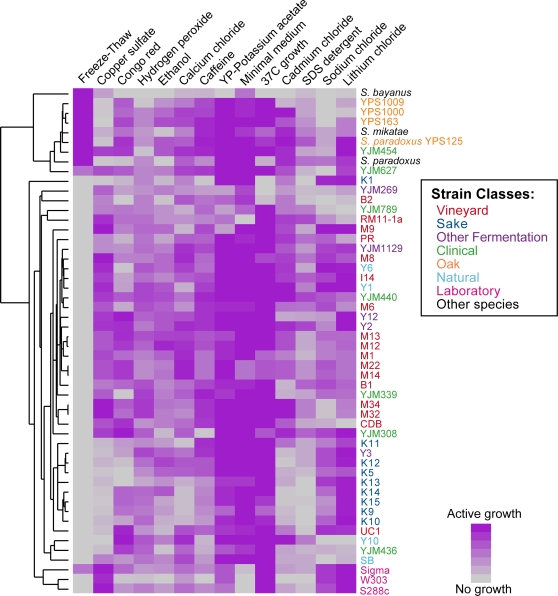
Phenotypic variation in diverse Saccharomyces
strains.The viability of 52 Saccharomyces strains and species
grown under 14 different environmental conditions was measured. Strains
were grown in at least duplicate on solid agar plates containing
1–3 doses of each environmental variable, as described in
Materials and Methods. Each row
on the plot represents a different strain and each column indicates a
given environment. Colored boxes represent the average growth score of
each strain grown in each environment, according to the key shown at the
lower right. Strains and conditions were organized by hierarchical
clustering using the Pearson correlation as a similarity metric.